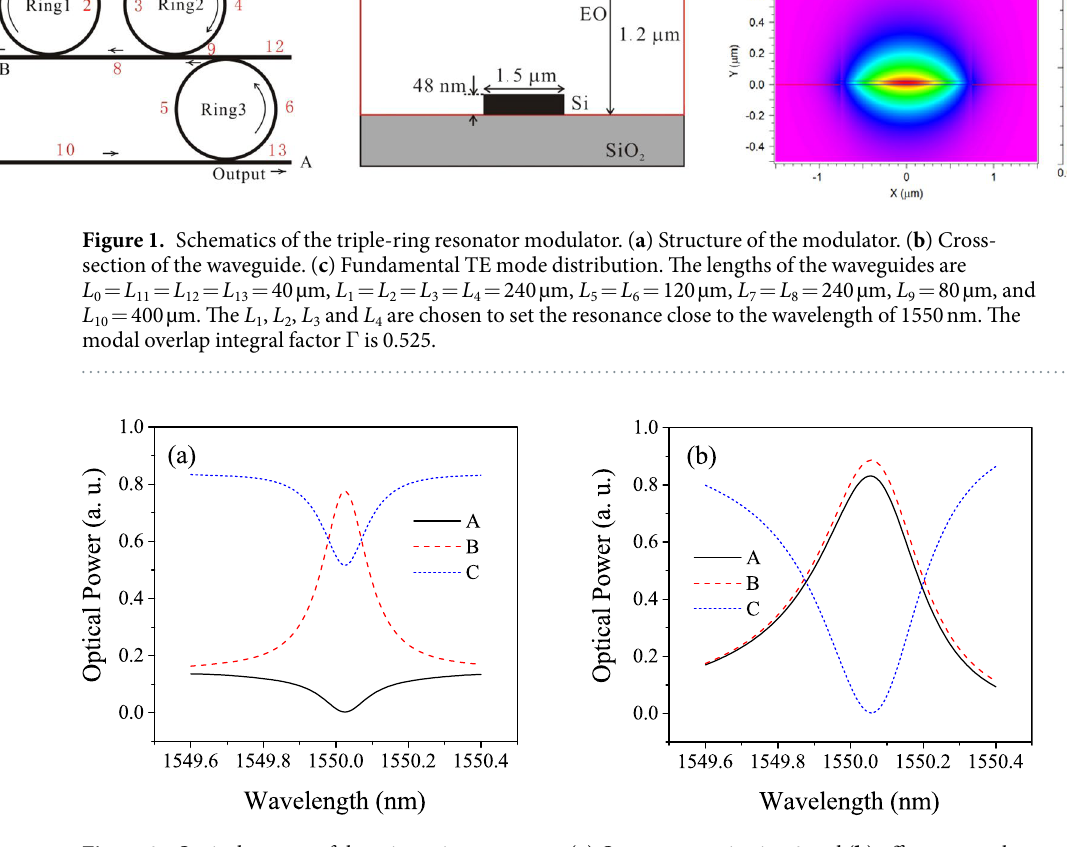
the refractive index, the cavity releases the light from the feedback path to port A. Even while in such an off state, rings 1 and 2 retain sufficient photon energy in the optical cavity, which is key for coupling intensity modulation. In order to operate the refractive index tunable microring resonator, we used a hybrid silicon and electro-optic (EO) polymer microring resonator 21 . We have previously shown that the waveguide modulator provides a large EO effect in device. The measured EO coefficient ( r 33 ) was higher than 100 pm/V at a wavelength of 1550 nm. Due to the relatively high refractive index of the hybrid waveguide, 100 μ m-diameter ring resonator with a high- Q was realized for the application of the EO ring resonator modulator 22 . Figure 1(b) shows the cross-section of the hybrid waveguide. We used ultra-thin silicon with a thickness of 48 nm and a width of 1.5 μ m as the core. This was then, covered by a 1.2 μ m-thick EO polymer layer. Figure 1(c) shows the calculated TE mode distribution across the waveguide. In such geometry, the waveguide enables the light propagation at the boundary of the silicon and EO polymer layers, thus the waveguide exhibits a suitable modal overlap for the EO modulation. The distribu- tion of the electric field is continuous in the vertical direction, while horizontal discontinuities at the boundaries of the silicon exist due to the large refractive index difference between silicon and EO polymer. Based on these experimental and theoretical properties, we utilized the step-segment dynamic method for the calculation of the coupling intensity modulation 23, 24 . The self-coupling coefficient ( t m ) and cross-coupling coefficient ( κ m ) at coupling points of m th microring are denoted by | t m | 2 + | κ m | 2 = 1 for a lossless coupling. For calculation of the optical transmission spectra, we chose = κ = κ = − 0.4i, and transmission loss of α = 4 dB/cm. The effective refractive index n κ 1 2 3 eff of the waveguide is 1.643. Ring 3 is tuned owing to the EO property of the hybrid waveguide. According to the expected change in the refractive index ( Δ n = 4 × 10 − 4 ) in ring 3, the spectral change of the output lights from ports A, B, and C are obtained as shown in Fig. 2. In port A, clear “ON” and “OFF” states can be seen at the center wavelength of 1550.02 nm. In the coupling intensity modulator, the dual-microring cavity stores optical energy. Therefore, the spectra of port B show relatively high- Q properties having 8,333 and 4,403 at the “ON” and “OFF” states, respec- tively. Furthermore, the modulator overcomes the cavity photon lifetime limitation.